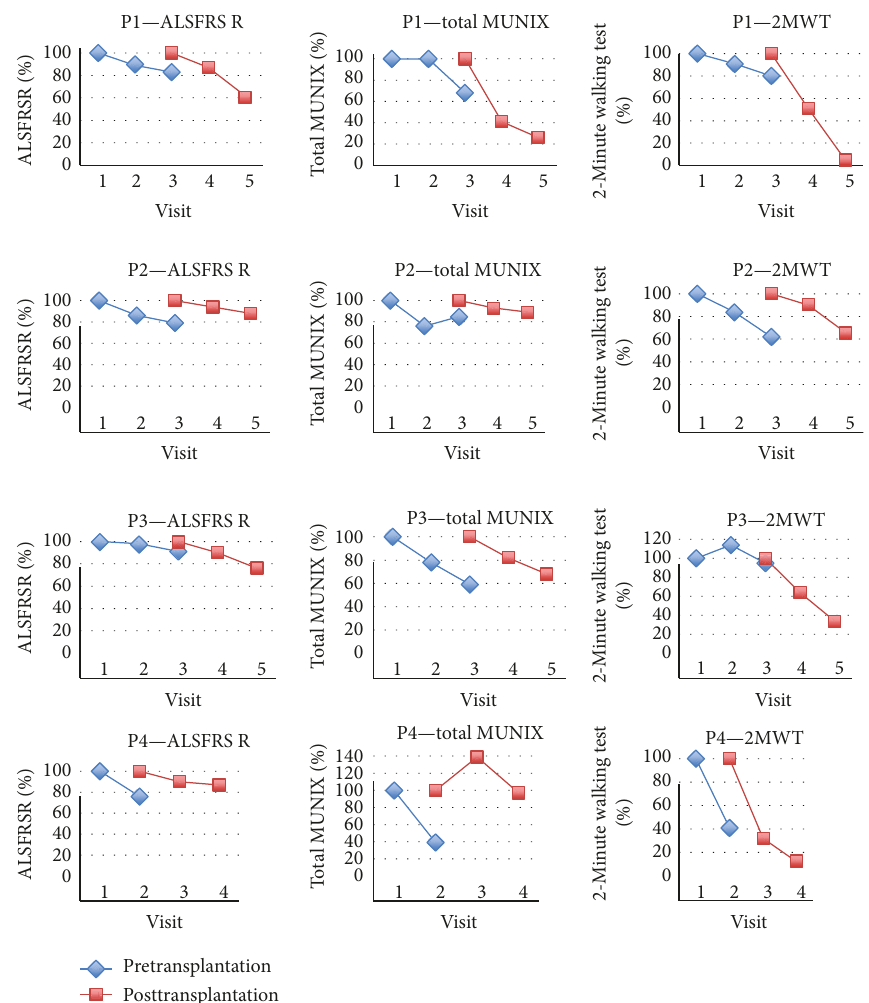
Figure 4: Functional tests. According to Figure 1 , functional tests evaluating muscle e ffi ciency in the upper (FAT) and lower limbs (2MWT, TUG, and 5STS) and trunk (TCT) were performed in several time points before, in the course of, and after ADRC therapy. The stability or decrease in these functions was compared with the trajectory of the ALSFRS scale. Impairment in all functional tests was observed faster than decrease in ALSFRS. Although 5STS and TUG showed good correlation with other functional parameters, their longitudinal use was limited in patients who were no longer able to stand up without the help of their arms/hands (on average 6 – 9 months after the fi rst transplantation; P3 and